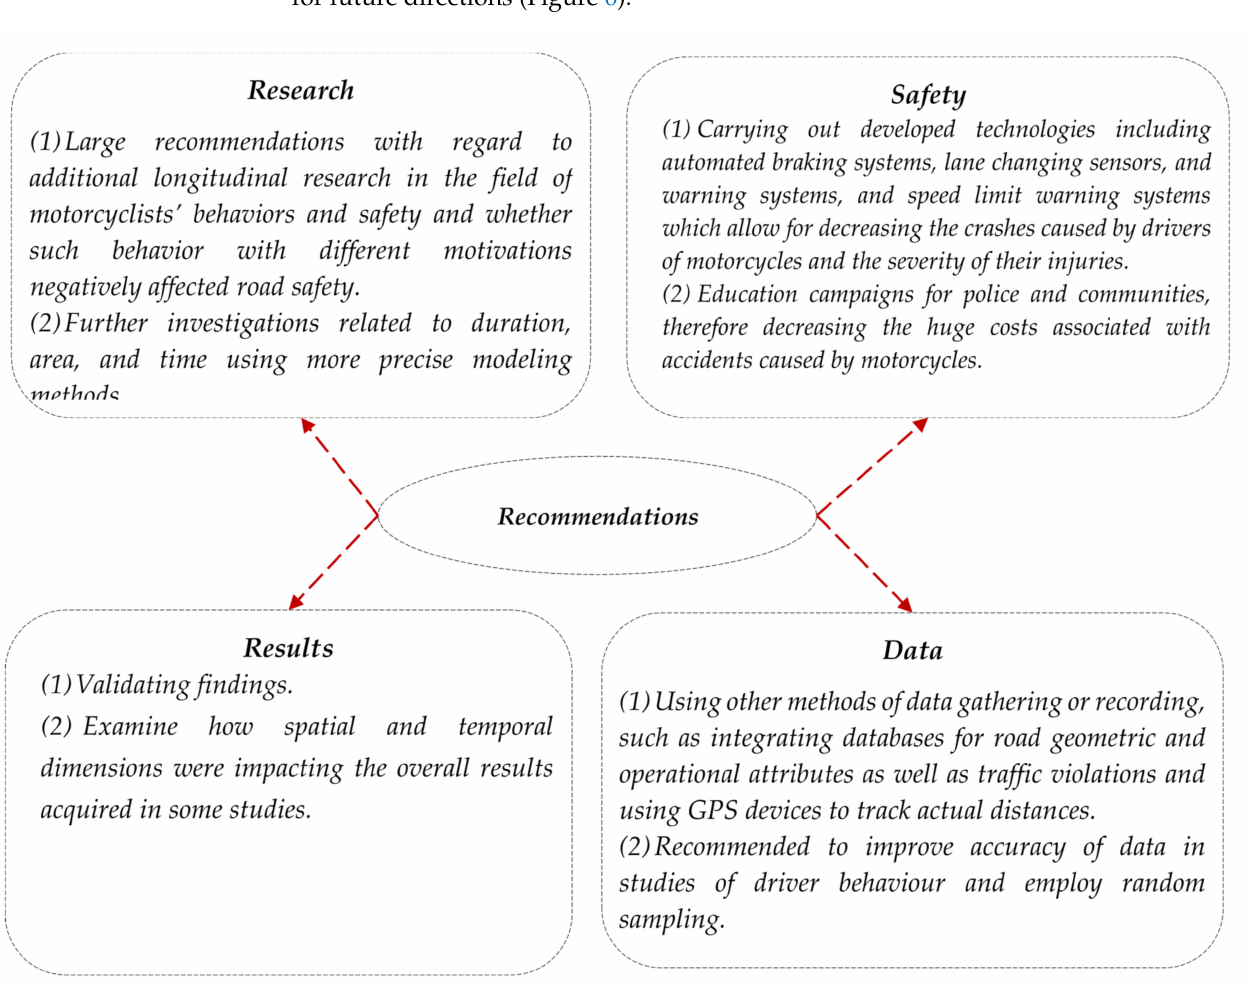
Figure 6. Recommendations